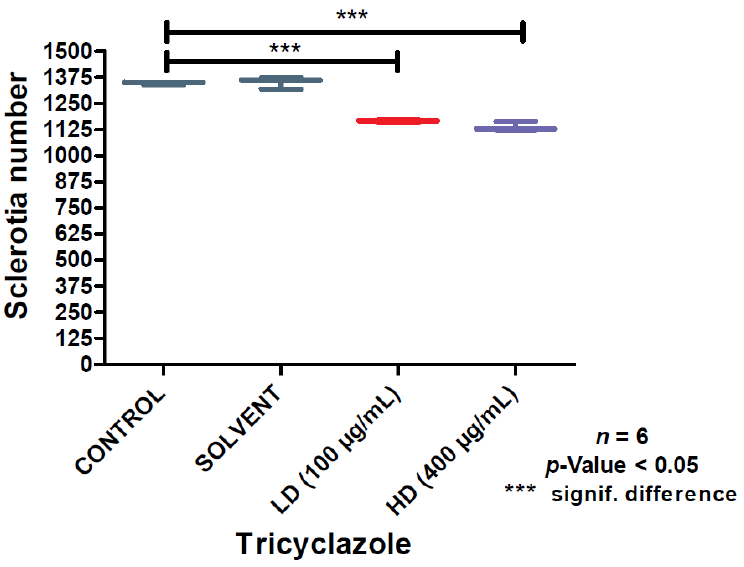
Figure 4. Effect of tricyclazole on S. cepivorum sclerotia melanization. Box and whiskers graph; the sclerotia were analyzed by using a Stratagene Eagle Eye II Imaging System TM on day 13 post-inoculation. ANOVA statistical analyses from 3 independent experiments were performed in duplicate. *** p < 0.05.